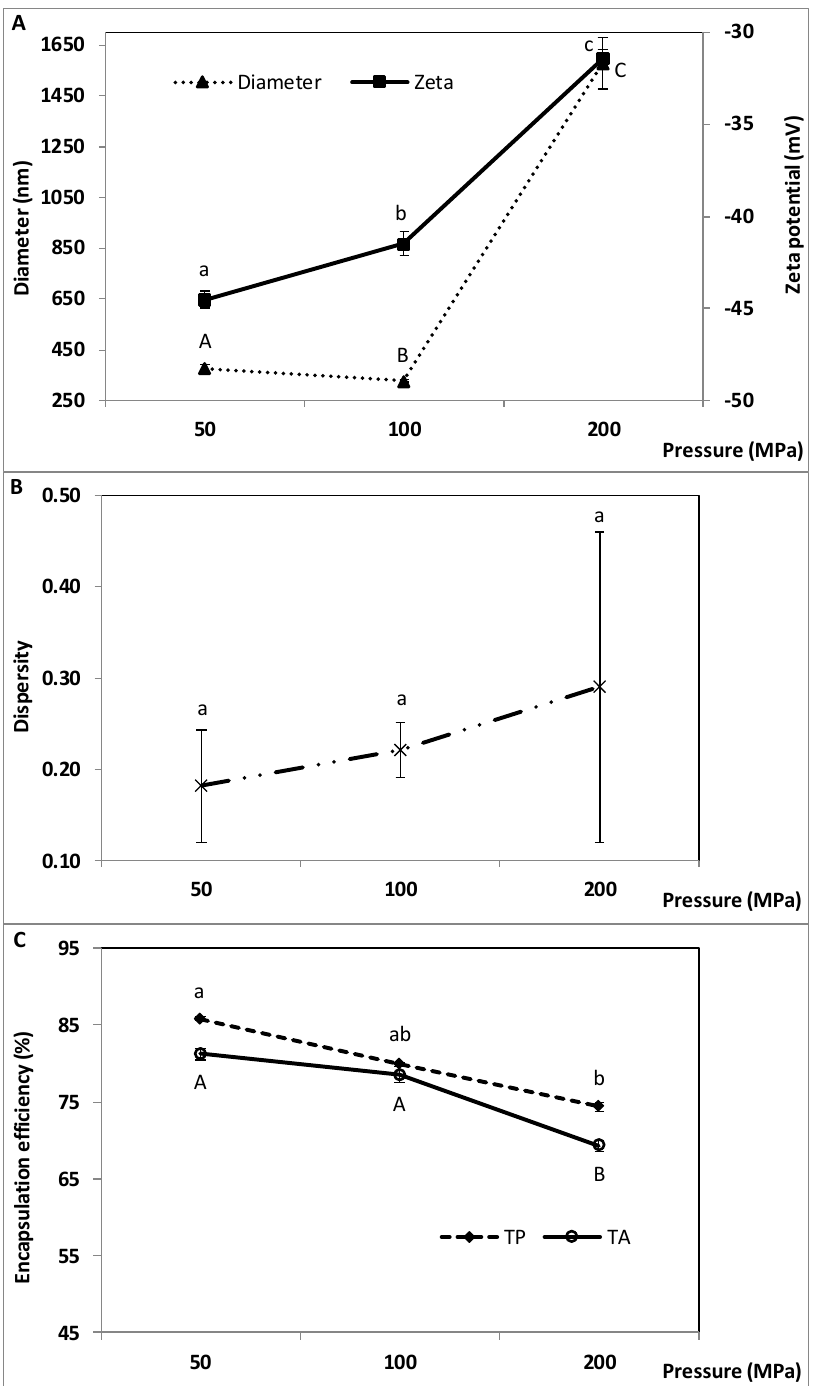
Figure 1. Effect of W 1 /O/W 2 homogenization pressure on the characteristics of the double emulsion, ( A ) droplet diameter, zeta potential, ( B ) size dispersity, and ( C ) encapsulation efficiency of total polyphenols (TP) and total anthocyanins (TA). W 1 /O homogenization speed and time: 10,000 rpm and 10 min; W 1 /O/W 2 homogenization speed and time: 6000 rpm and 15 min. Means (three replicates) ± standard deviation (SD). Means with different letters in each series are significantly different ( p ≤ 0.05).